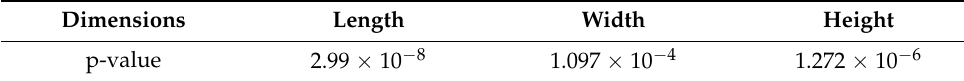
Table 5. P-values of NN-predicted